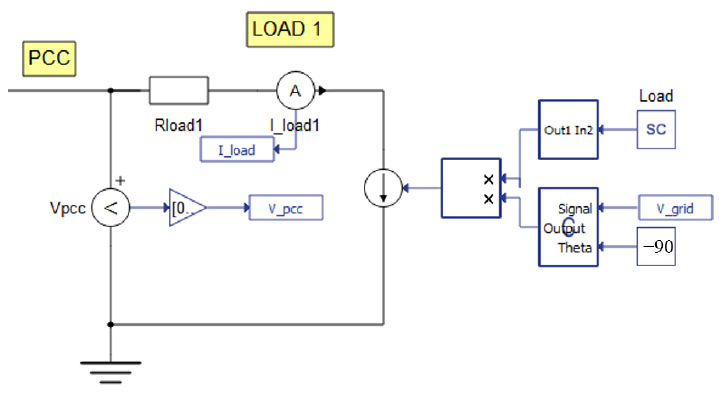
Figure 14. Main load in HIL experiment block.